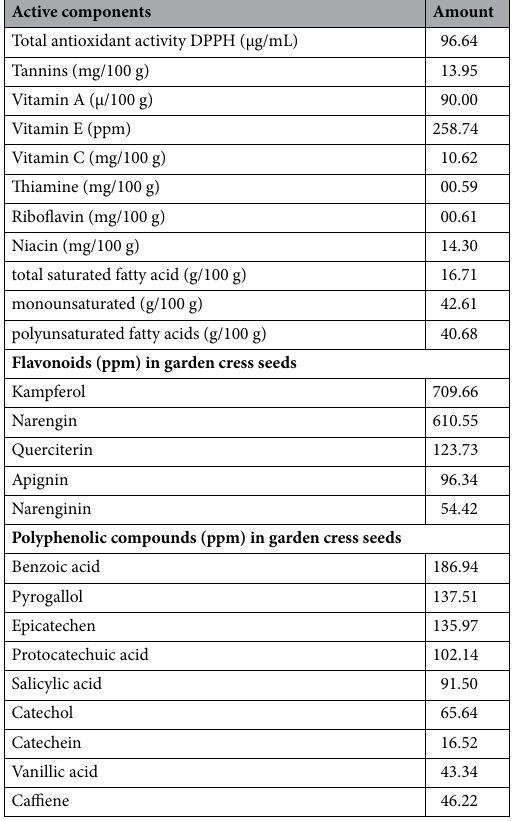
Table 1. Active components of garden cress seeds (per dry matter). Source: Halaby et al. 9